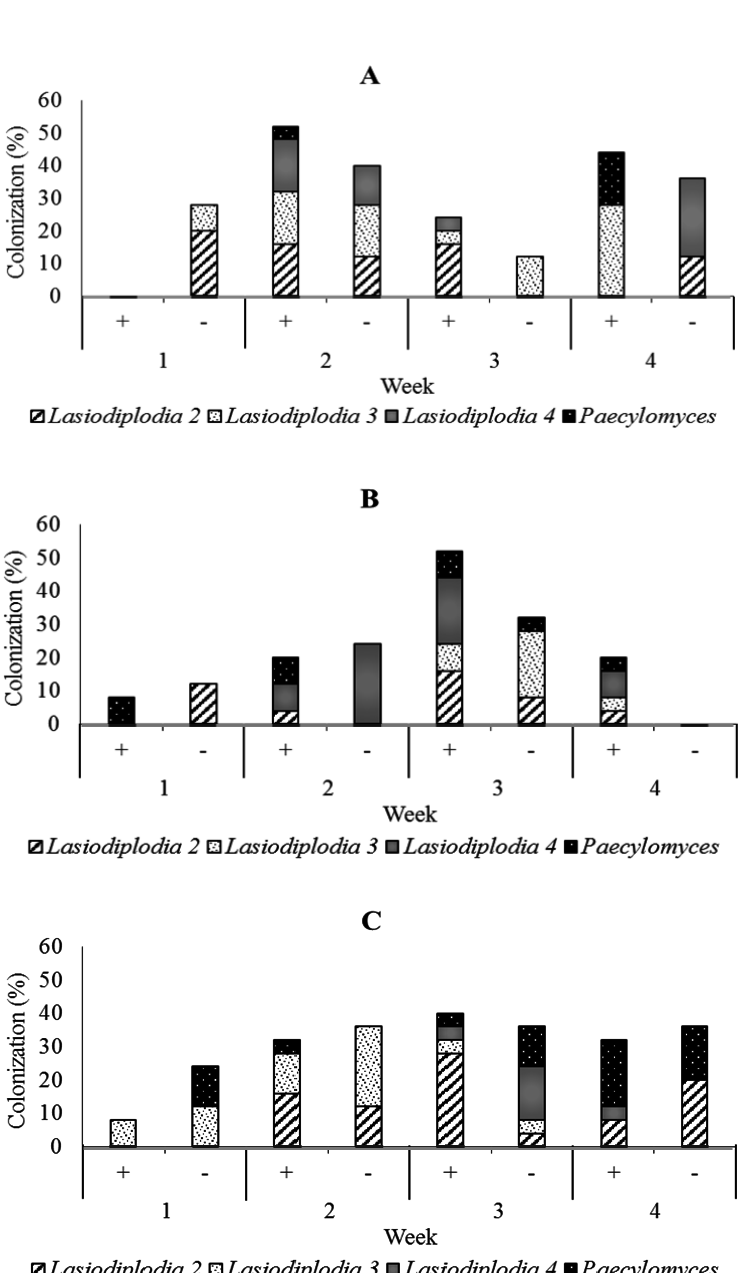
Fig. 6. Dominant fungal endophytes colonizing leaf (A), stem (B) and root tissues (C) of five-month-old seedling at one, two, three, and four weeks after Trichoderma asperellum inoculation through soil drenching. +, with T. asperellum ; -, without T.